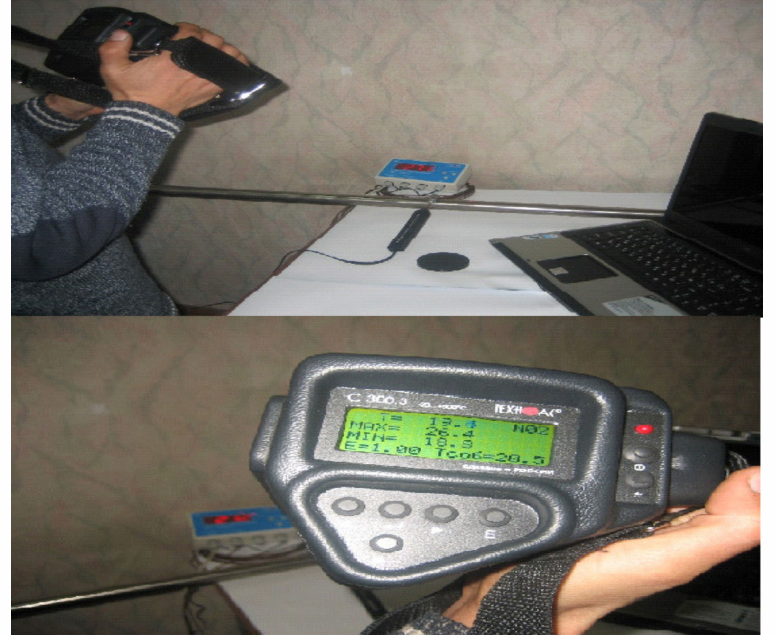
Figure 7. Checking temperature sensors using an infrared pyrometer with 300-3 “Photon”. Figure 8 shows a cup anemometer for measuring wind